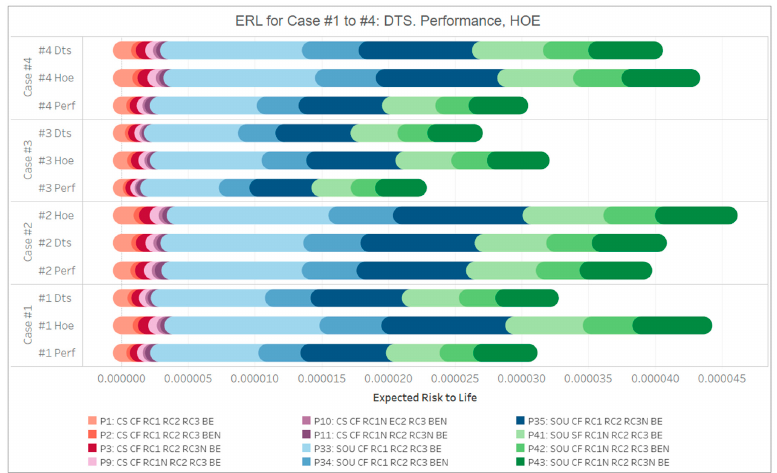
Figure 7. ERL for design scenarios for Case #1 to #4. Note: CS—Concealed Space, CF—Challenging Fire, RC1—Robustness Check Detection Failure, RC2—Robustness Check Sprinkler Failure, RC3—Robustness Check Building Alarm Failure, BE—Blocked Exit, SOU—Sole Occupancy Unit (not CS), BEN—Exit is NOT Blocked.